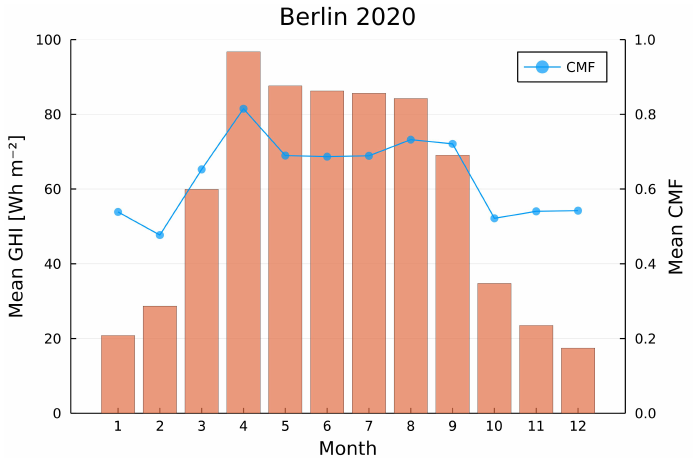
Figure 1. Daily mean global horizontal irradiation (GHI) for each month (orange bars, left axis) and monthly mean cloud modification factor (CMF, blue curves, right axis) for Berlin in 2020. The results for the other three cities can be found in Figure A1 in Appendix